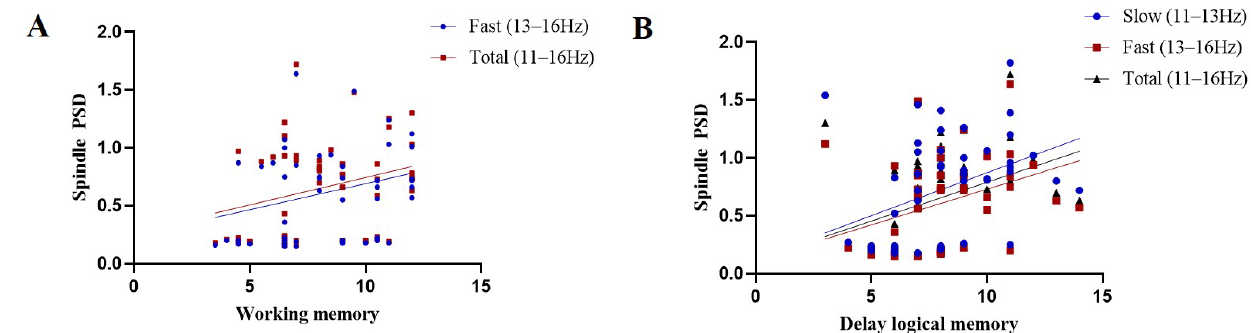
Figure 3. Correlation results of sleep spindle power spectral density and memory function. ( A ) the relationship sleep spindle power with logical memory; ( B ) the relationship sleep spindle power with working memory.